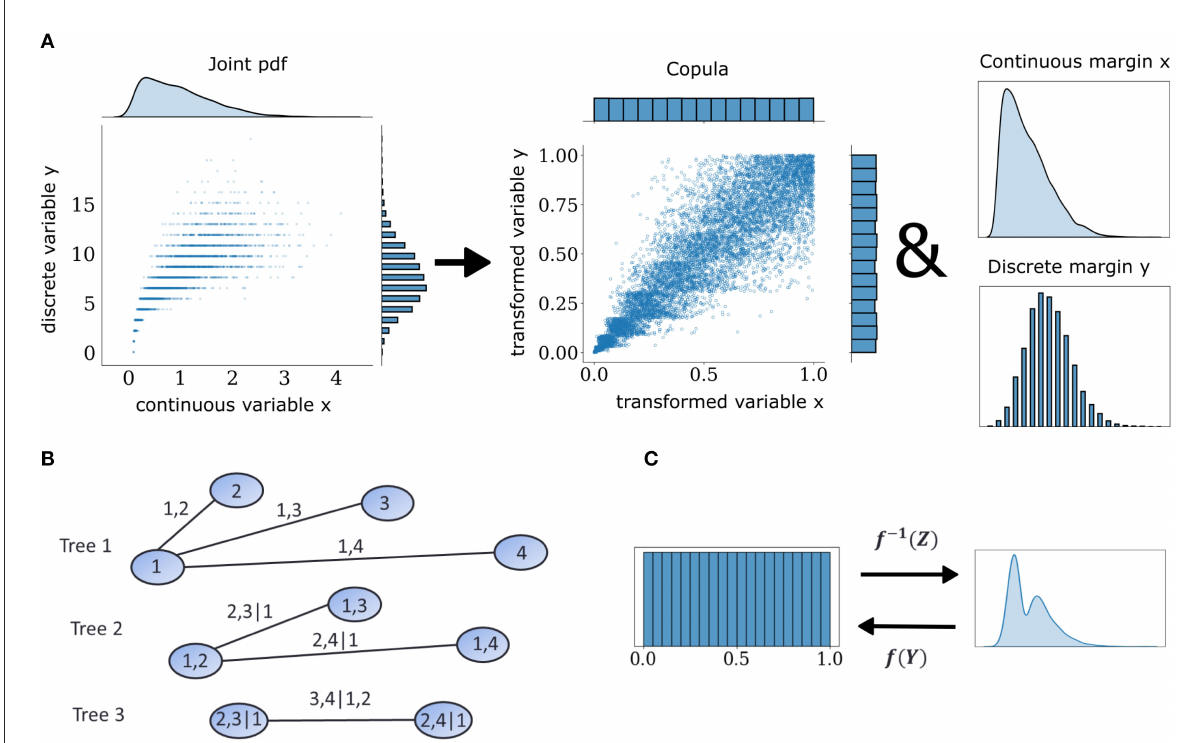
FIGURE1 Mixed vine copula flows. (A) Samples from mixed variables of any joint probability density function (pdf) can be decomposed into their margins and a copula. Copulas are extracted by transforming continuous and discrete samples to uniform through the probability integral transform. (B) Graphical illustration of a C-vine for four variables. Nodes and edges of the first tree denote the variables and bivariate dependencies, respectively. Edges of subsequent trees denote dependencies that condition on one or more variables. (C) Illustration of forward and inverse normalizing flow transformation f of base distribution Z and target distribution Y